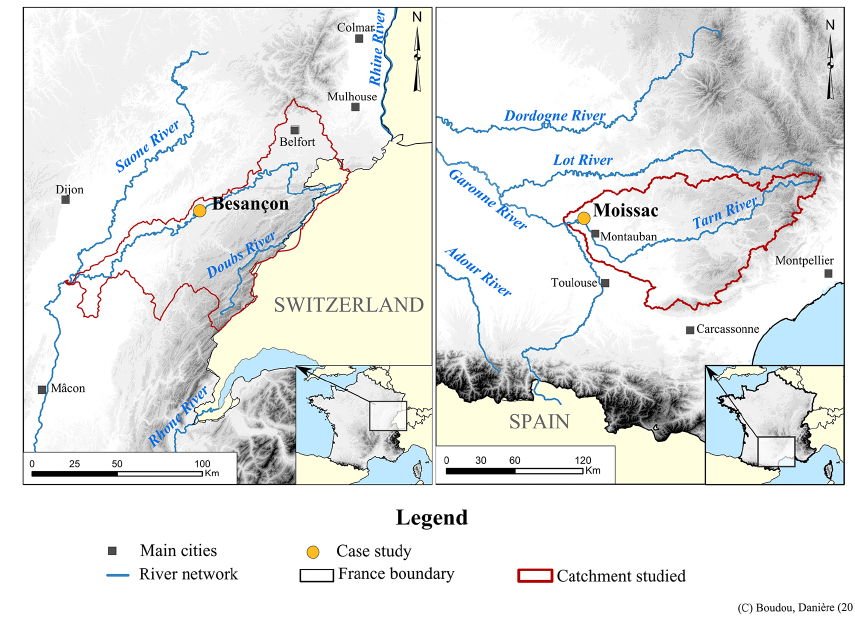
Figure 2. Location of the case studies: Doubs Basin and Besançon (left panel), Tarn Basin and Moissac (right